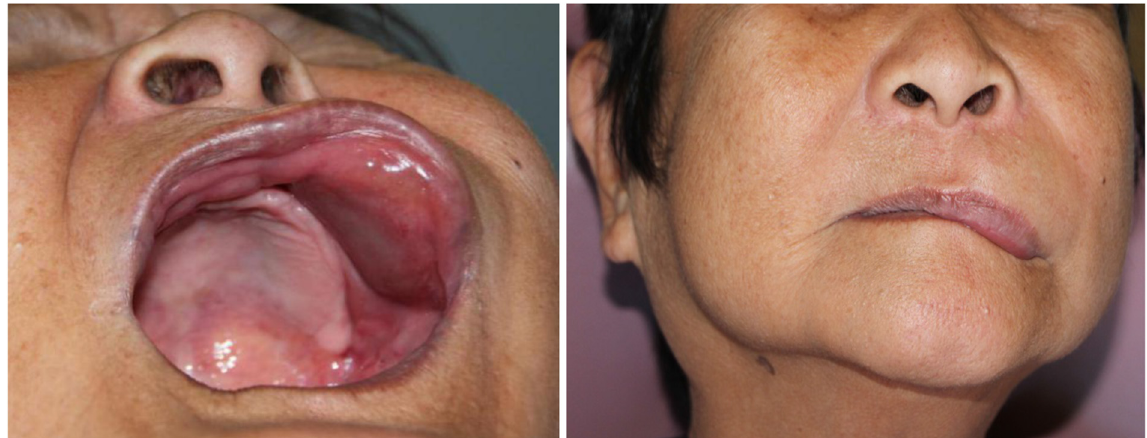
Fig. 1. Local examination on the lymphoma of the left lip.